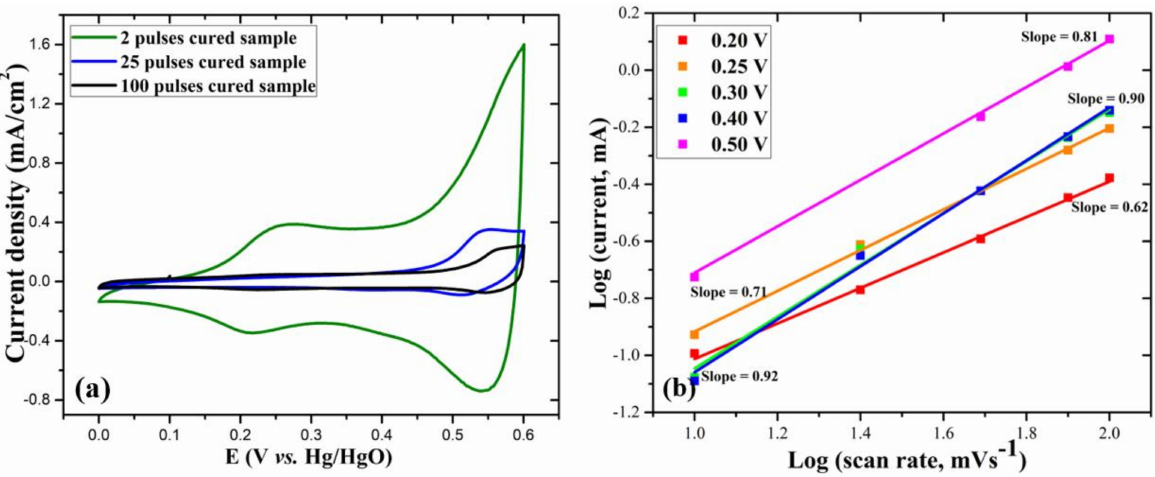
Figure 7. ( a ) CV curves at 30 mV/s scan rate for different electrodes and ( b ) log ( i ) versus log ( v ) plot at various potentials for the 2 pulses cured